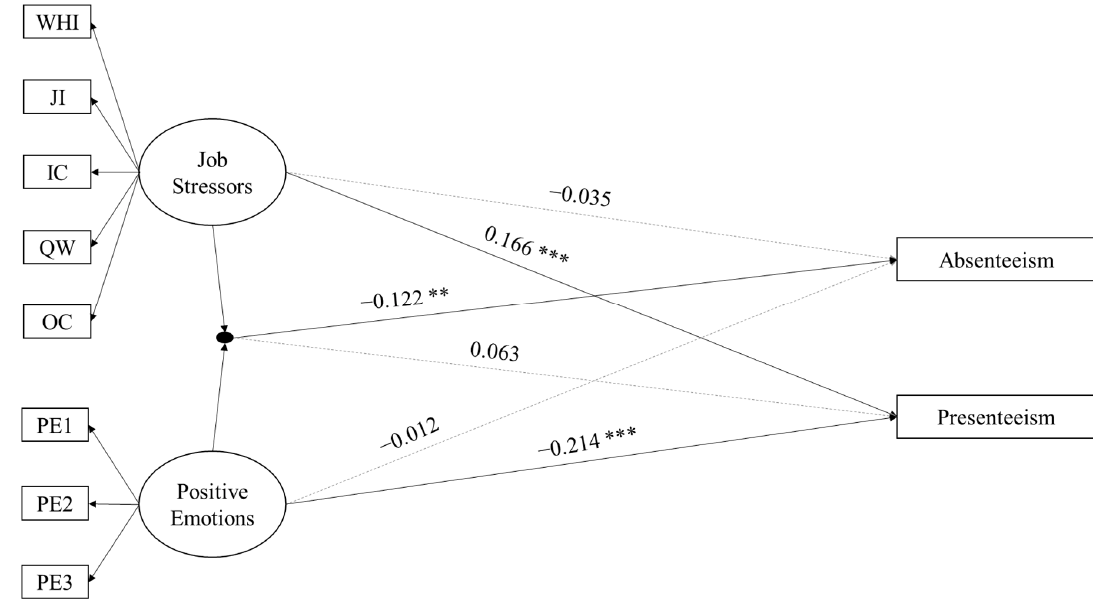
Figure 2. The moderating role of positive emotions in the relationships between job stressors and absenteeism / presenteeism. Note. * p < 0.05; ** p < 0.01; *** p < 0.001. WHI = work / home interface; JI = job insecurity; IC = interpersonal conflict; QW = quantitative workload; OC = organizational constraints.